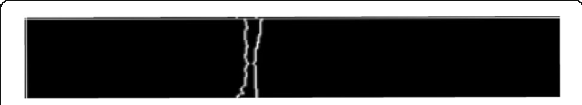
Fig. 7 Morphological processing results based on stroke coding